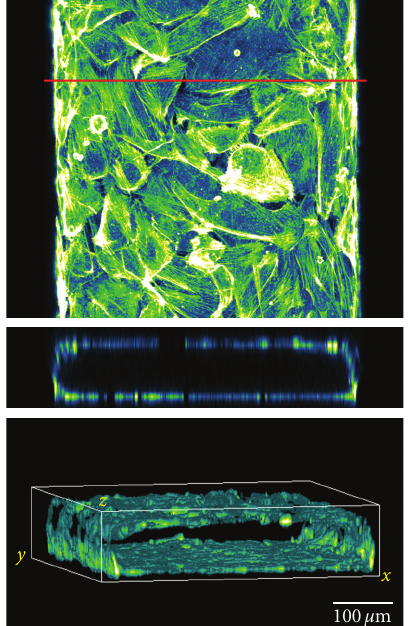
Figure 6: Covering all surfaces of a microfluidic channel yields “artificial capillaries.” Human endothelial cells were cultured in a PDMS microfluidic channel and allowed to cover all surfaces. After overnight culturing, cells were fixated and actin filaments were imaged with confocal laser scanning microscopy. Top image is a pseudocolored top view of the microfluidic channel. The red line marks the section that was used to construct a front view of the channel (middle image). The bottom image is an isometric volume view of the same